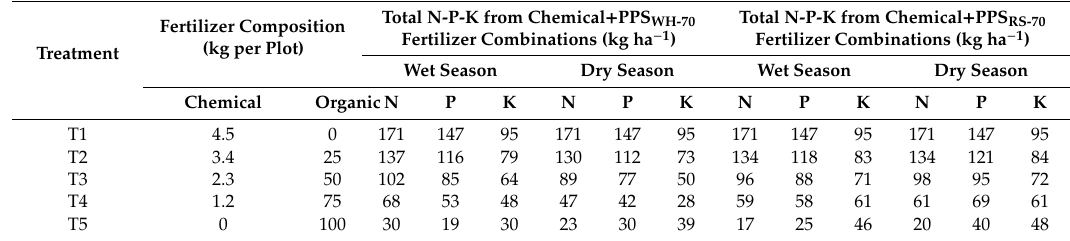
Table 4. Composition and doses of chemical and organic fertilizers and total amount of nutrients (N − P − K) applied in the cucumber vegetable production during the wet and dry season growing periods.